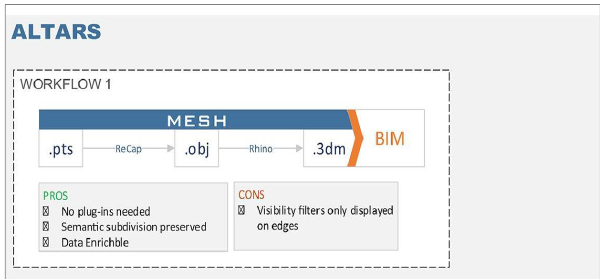
Figure 16. Diagram that shows the results of workflow 1 on the